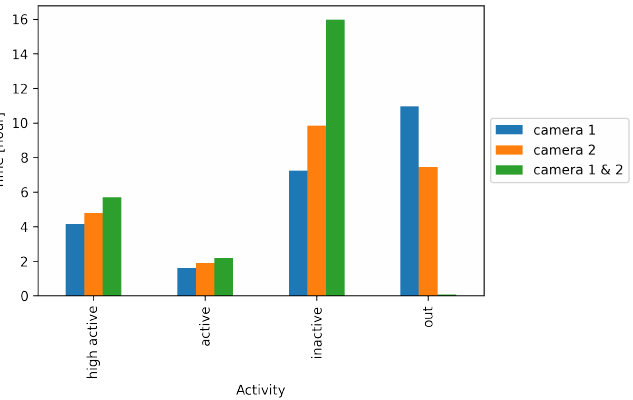
Figure 10. Condensed 24-h activity overview per camera and both cameras evaluated together.